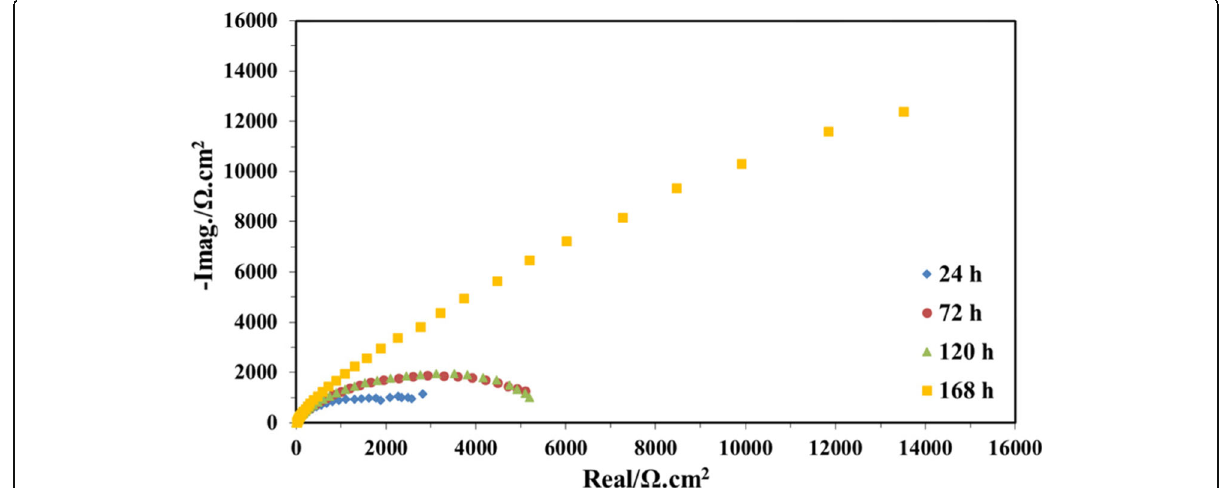
Fig. 8 Nyquist curves for steel samples immersed for different periods in NaCl brine containing 3% (v/v)